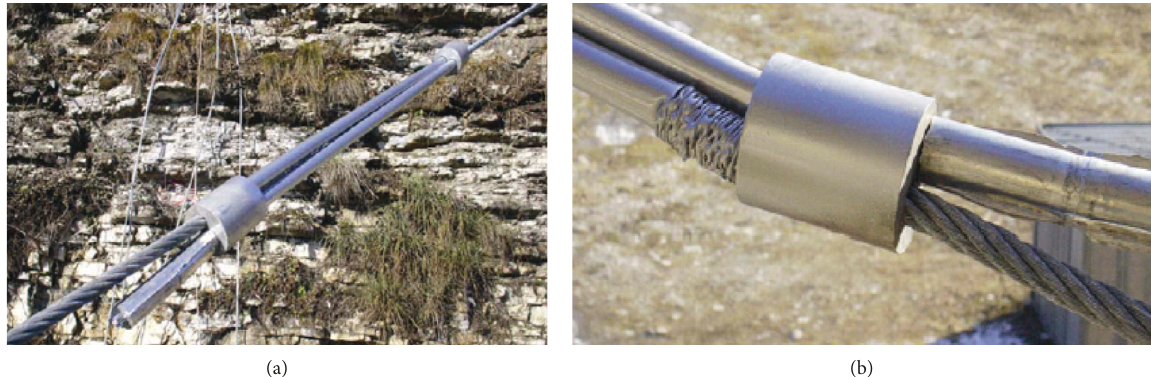
Figure 2: Pictures of the tube-crushing dissipator [15]: (a) before use; (b) after use.